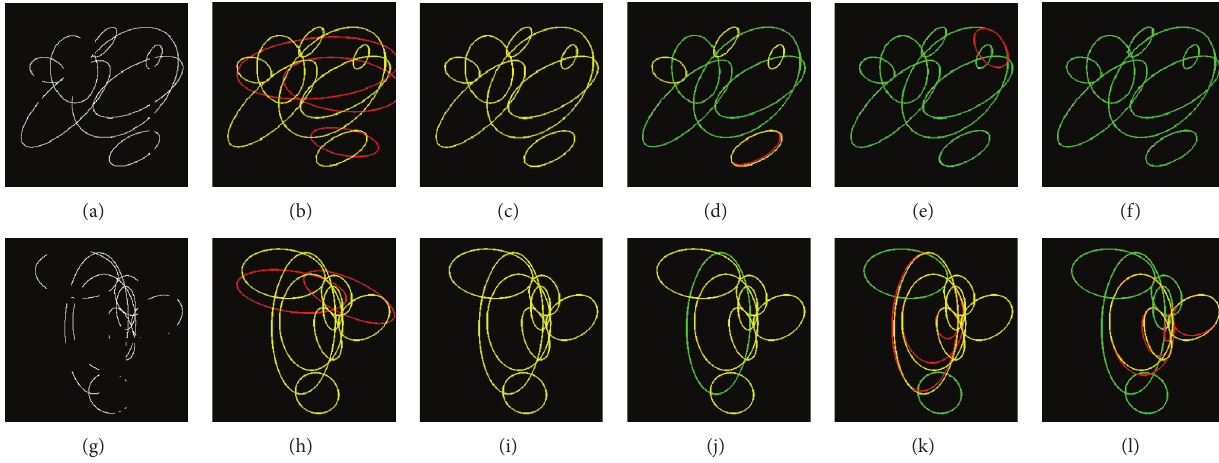
Figure 14: Two sets of detection results by each method. (a, g) are two images with 10% and 50% blocked, (b, h), (c, i), (d, j), (e, k), and (f, l) are the detection results by RHT, UPW, KIM, MAI, and the proposed method, respectively, where the meaning of each color is the same as Figure